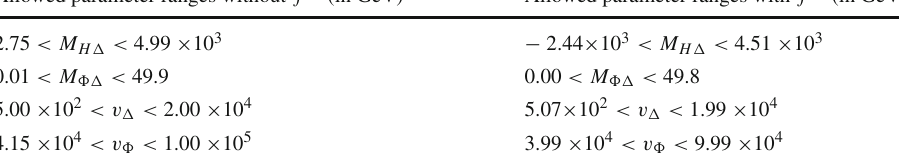
Allowed parameter ranges without f H (in GeV) Allowed parameter ranges with f H (in GeV) dimensionful parameter space after DM constraints 2.75 < M H (cid:2) < 4.99 × 10